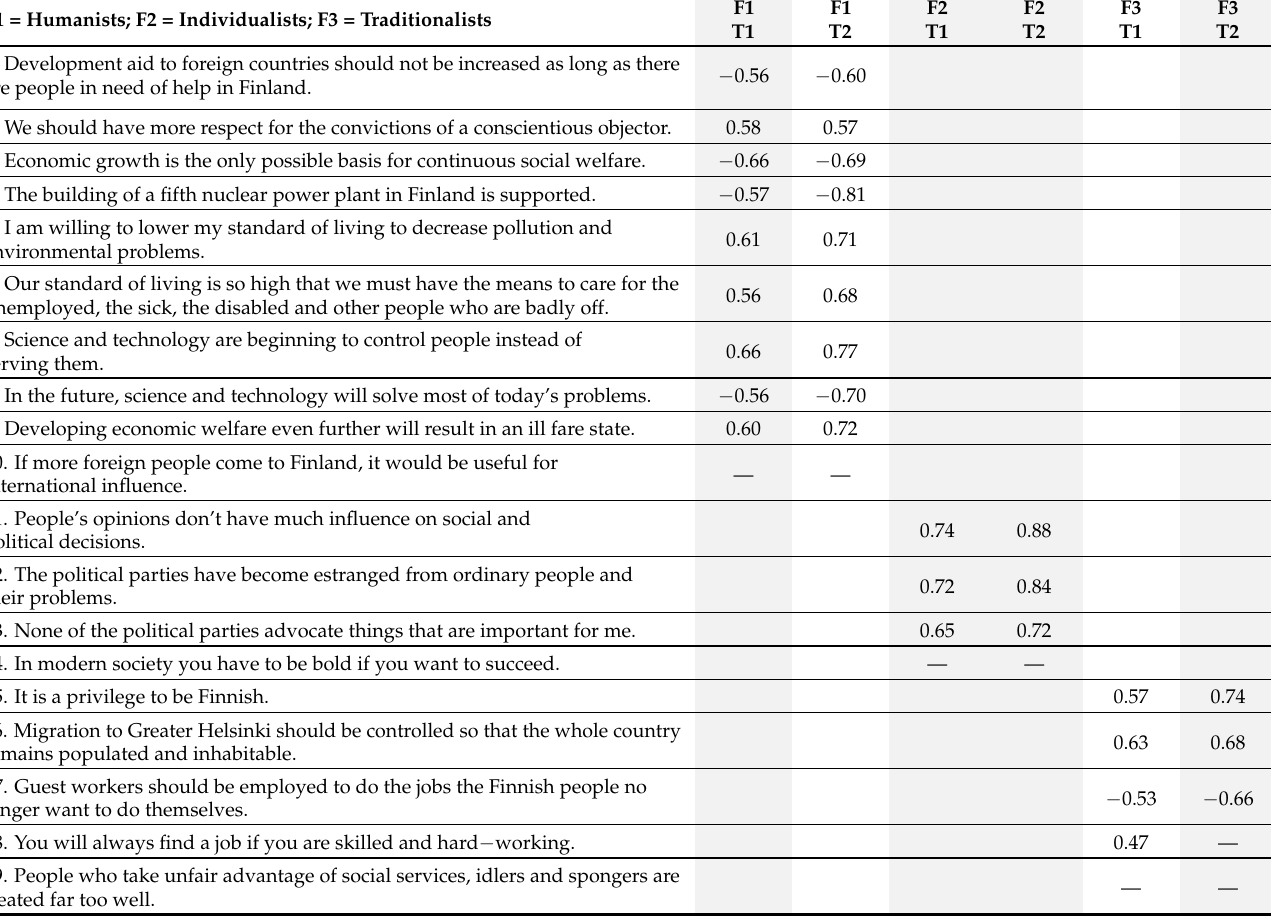
Table 1. Generation X: Factors and loadings in the three-factor solution in 1992 (T1) and 1995 (T2). How to read the tables: Factors are interpreted as different attitude structures (e.g., in Table 1 F1 Humanists, F2 Individualists, and F3 Traditionalists). The loadings close to 1 or − 1 indicate that the factor is strongly influenced by the statement (variable). In Table 1, in research phase T2,